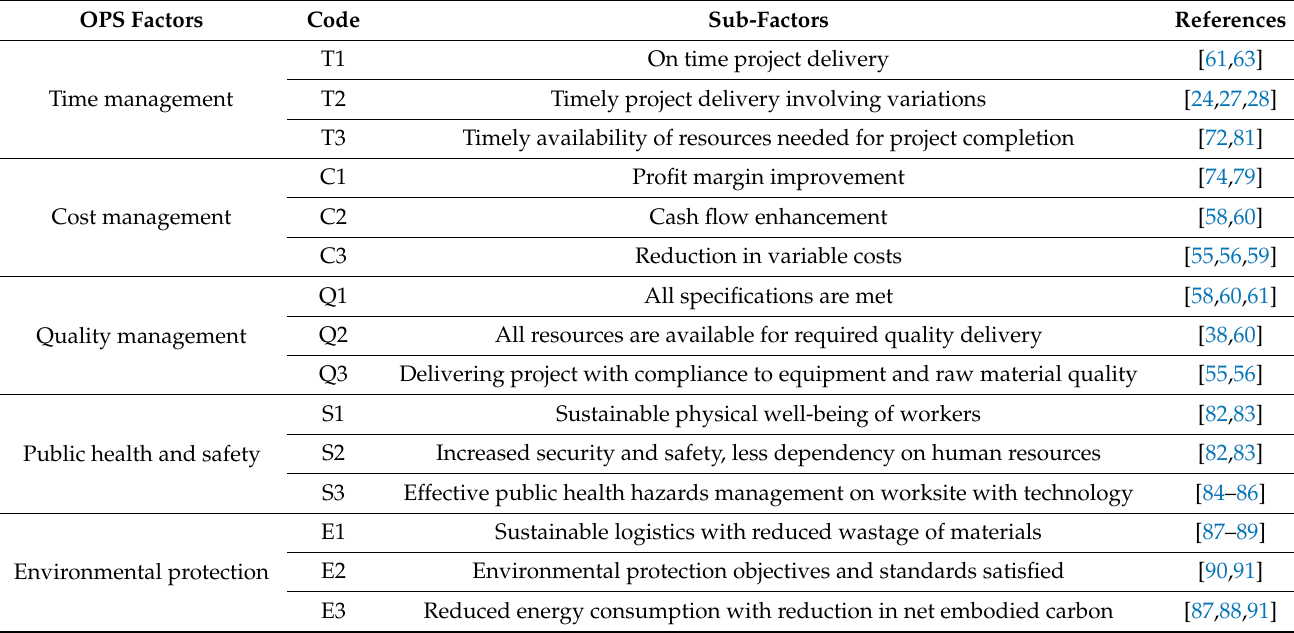
Table 2. Factors leading to overall project